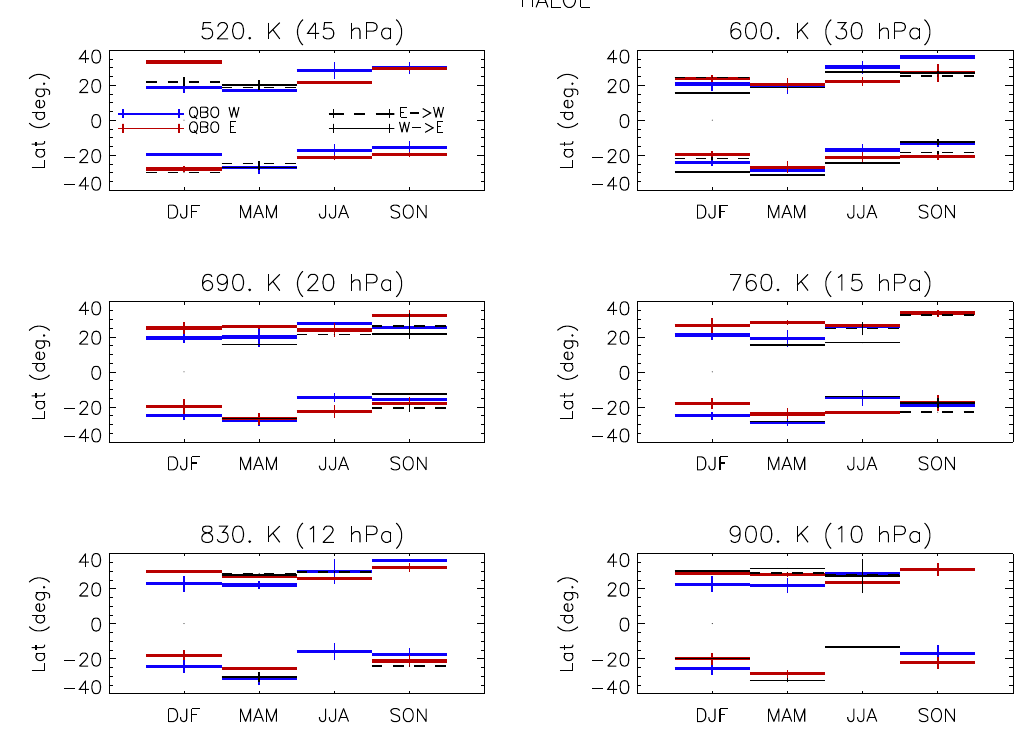
Fig. 9. QBO composite of the subtropical barrier annual cycle based on 14yr HALOE data. Blue (red) lines denote the mean seasonal position during QBO westerly (easterly) phase. Black solid (dashed) lines denote occurrence of a transition within the three months period from westerly (easterly) to easterly (westerly) winds.